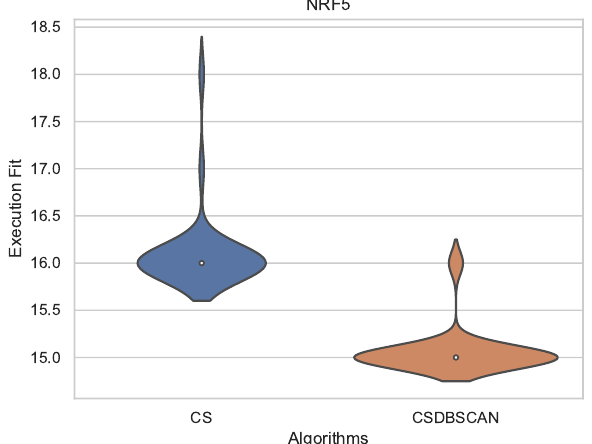
Figure 12. Instance NRF.5 distribution.